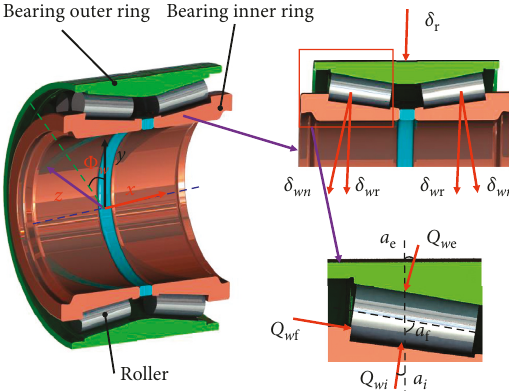
Figure 2: Force diagram of the axle box